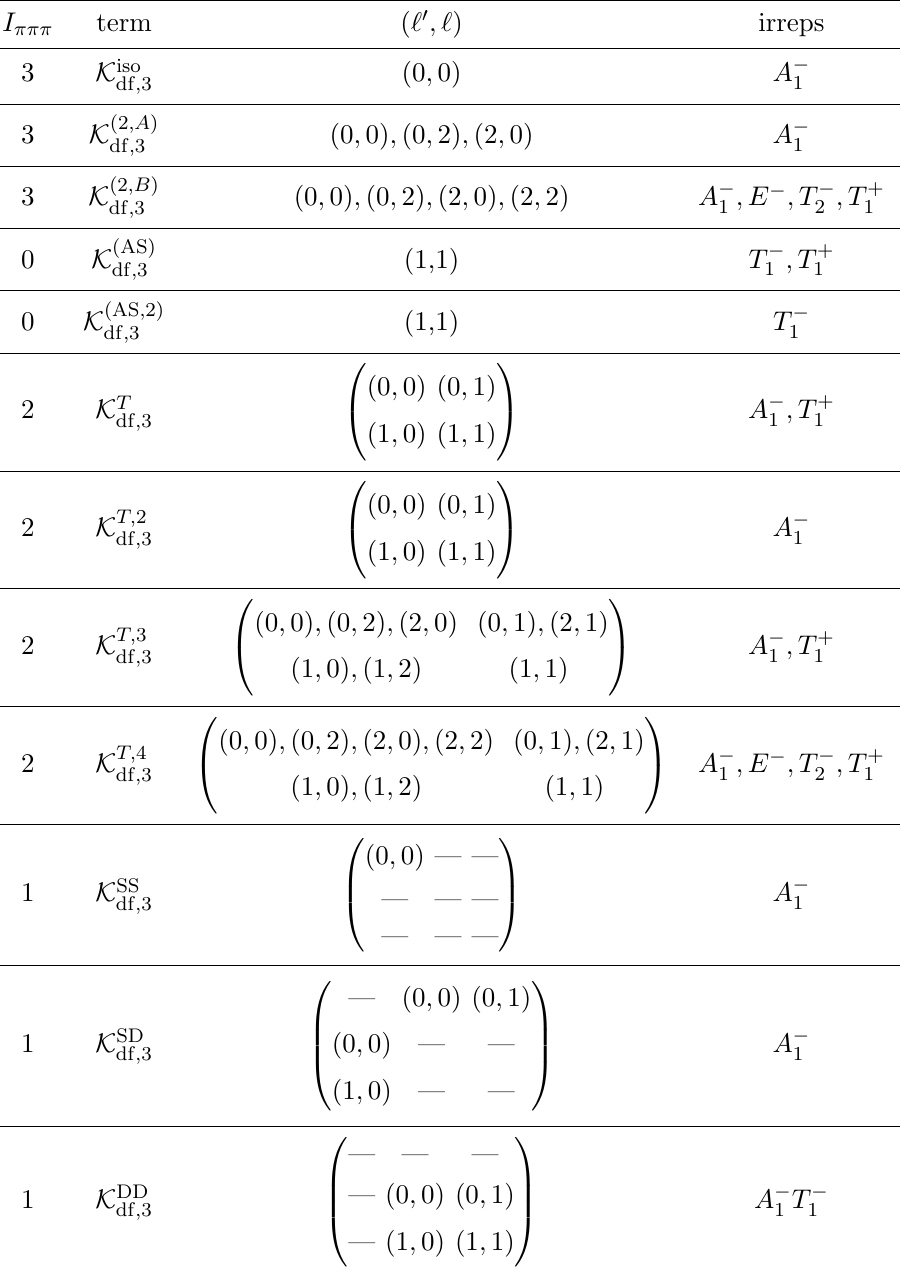
Table 3 . Properties of low-order terms in the threshold expansion of K df ; 3 . The terms are speci- (cid:12)ced by their coe(cid:14)cients in eqs. (3.7), (3.12), (3.27), and (3.30). The values of ( ‘ 0 ; ‘ ) are obtained by decomposing the expessions into the k‘m basis, following the method of ref. [22]. The matrix structure corresponds to the isospin decomposition of appendix C, which is also used in the afore- mentioned equations. The (cid:12)nal column lists the cubic-group irreps that are present in (cid:12)nite volume when one considers the rest frame, P = 0. The superscript gives the parity, which includes the intrinsic negative parity of the three-pion state. The irreps are determined by (cid:12)rst working out which J P values are present, and then subducing to the cubic group. Results for I (cid:25)(cid:25)(cid:25) = 3 are taken from ref.